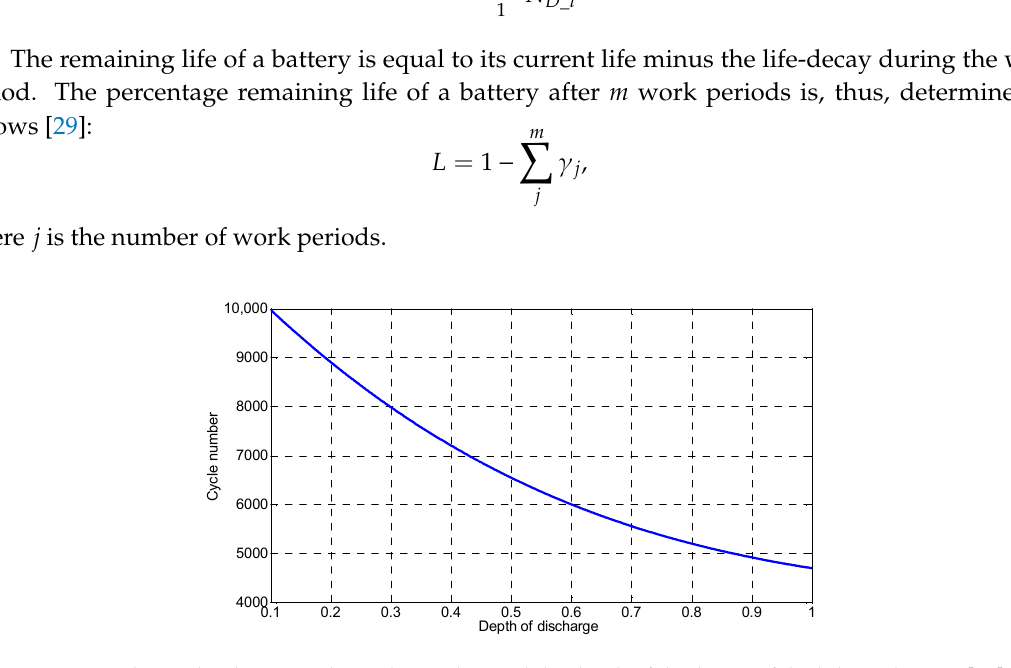
Figure 3. Relationship between the cycle number and the depth of discharge of the lithium battery [29].